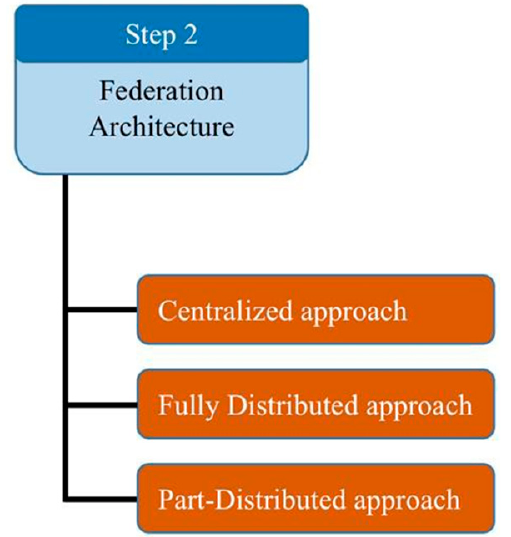
Figure 8. Federation architecture (Step 2).